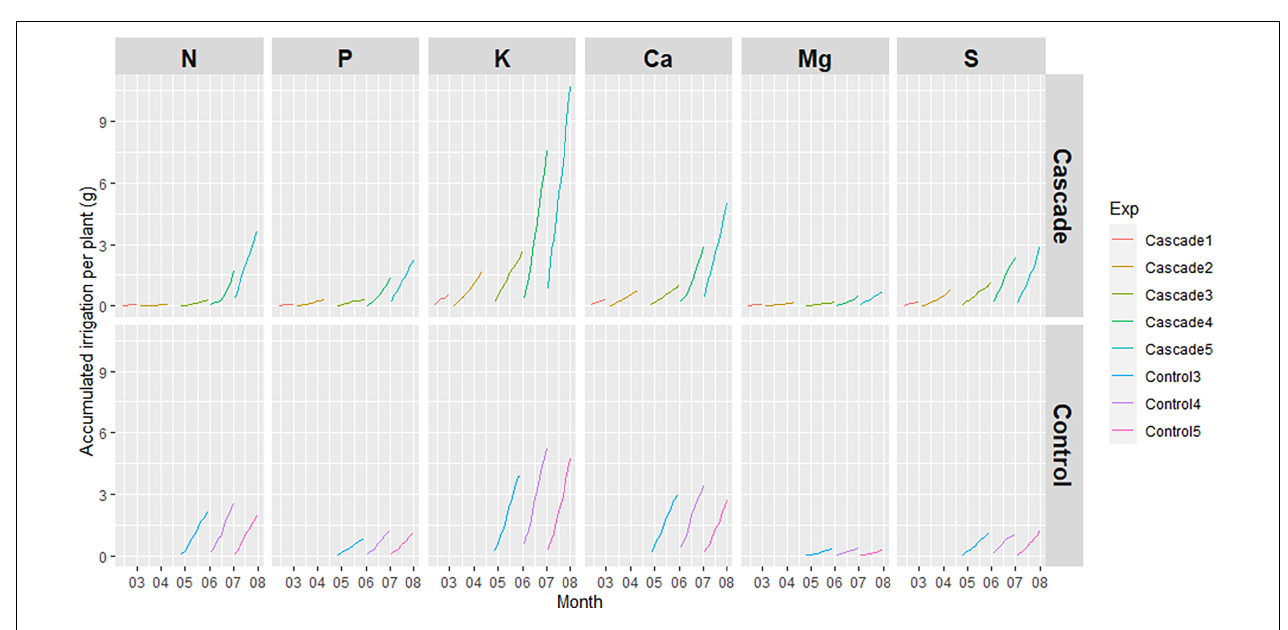
FIGURE 4 | Electrical conductivity (EC). Highlighted area represents the suitable EC range to grow hydroponic lettuce stated by Singh and Dunn (2016).